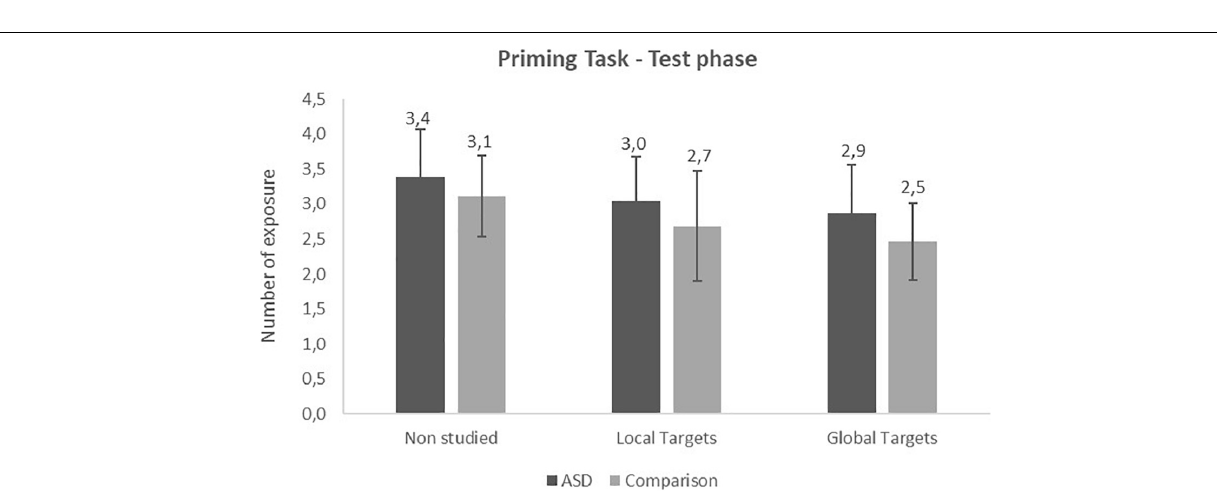
FIGURE 3 | Priming task: number of exposure at the test phase (Mean and